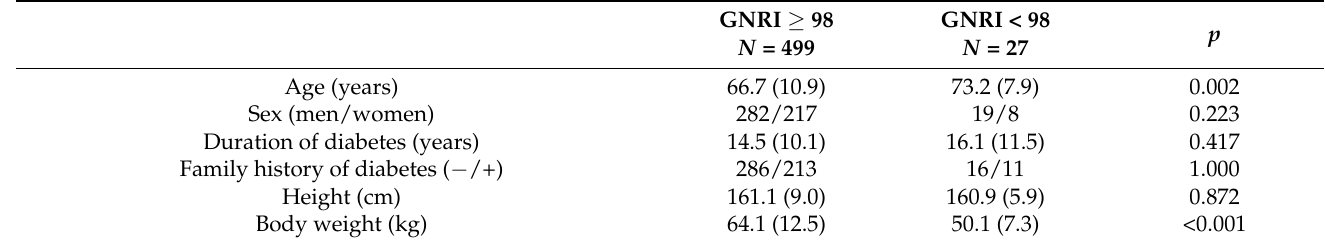
Table 2. Clinical characteristics according to geriatric nutritional risk